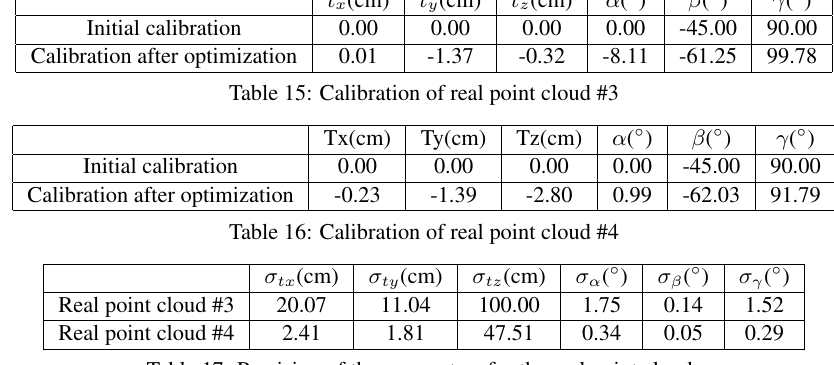
Table 17: Precision of the parameters for the real point